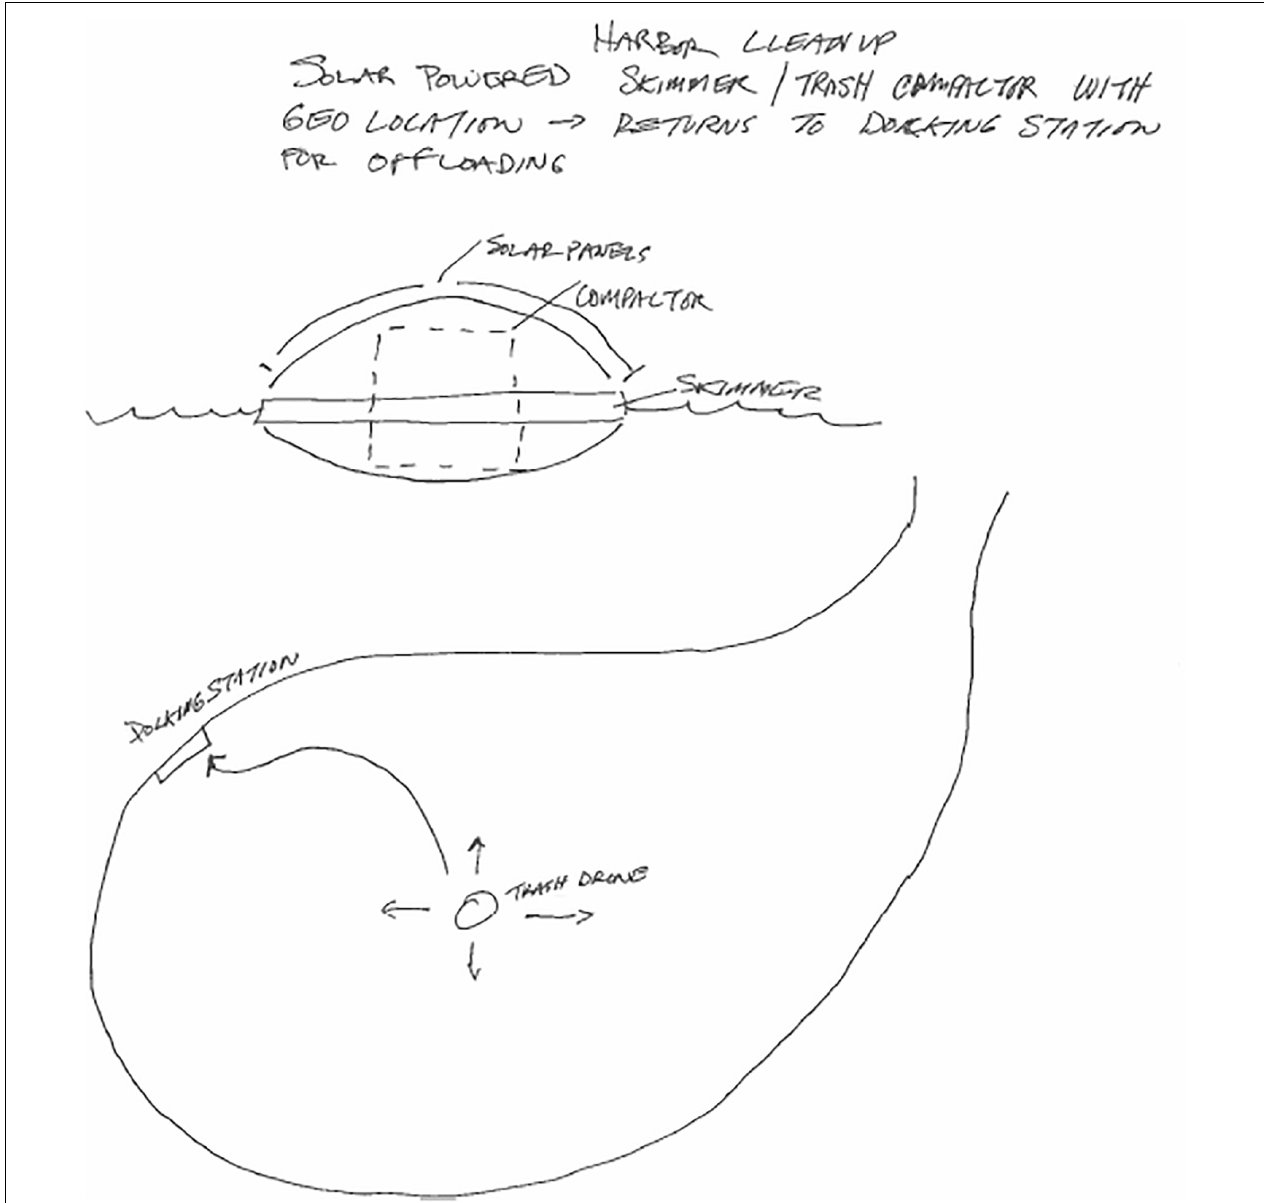
FIGURE 6 | A solar-powered trash skimmer that cleans up harbors that received an originality score of